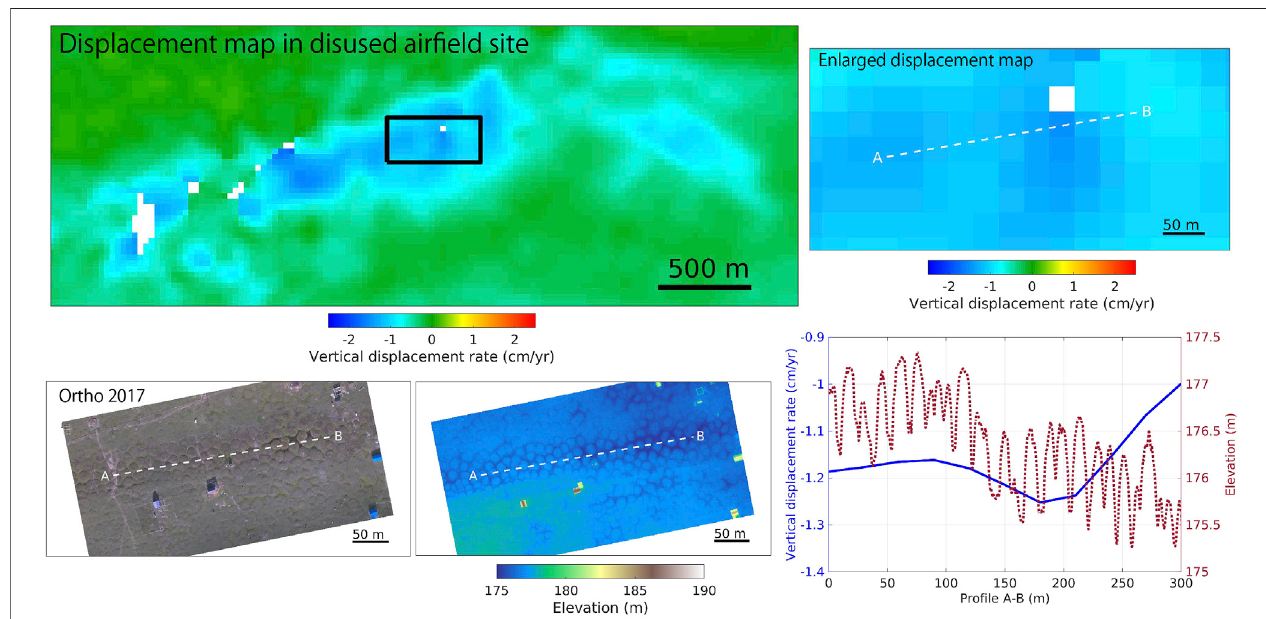
FIGURE 7 | Comparison between InSAR and UAS maps at area T4. The displacement map (upper left) is the same as Figure 2B with 30-m resolution. (upper right) Enlargeddisplacementmap (lowerleft) Orthorecti fi edandDSMmapsin2017. (lower-right) comparisonbetweenelevationandverticaldisplacementratealong line transect (A – B) .